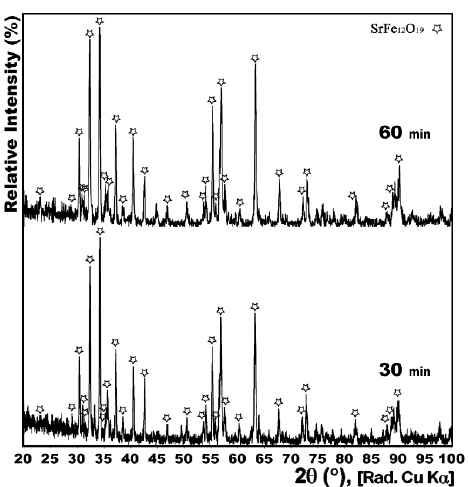
Figure 9. XRD patterns of the CH 4 heat treated powder calcined at 1100 °C for 0.5 and 1 h. Table 2. Summary of all samples with different calcination conditions and their products. Different conditions of the re-calcination process are summarized in Table 2. Observed Phases